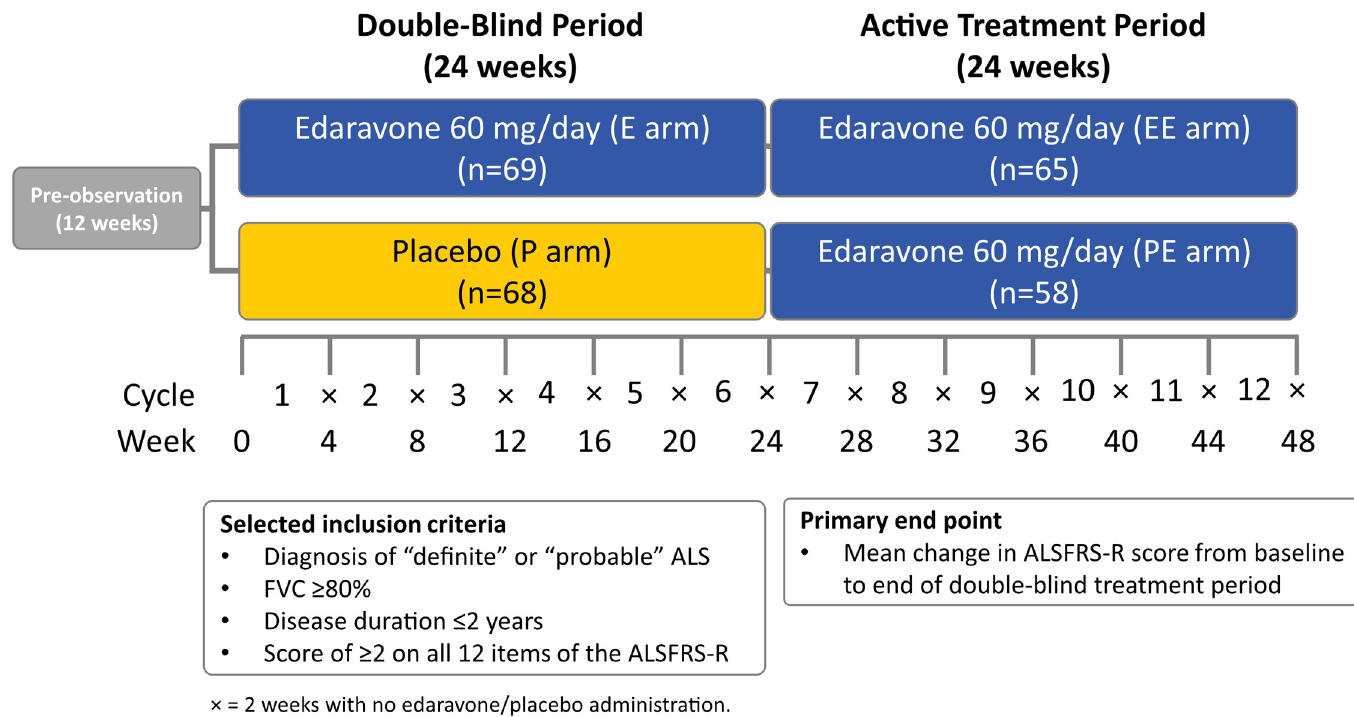
Fig 1. Study design for edaravone Study 19. After a 12-week pre-observation period, eligible subjects were randomized to receive either edaravone or placebo during a 24-week, double-blind period. After the double-blind period, subjects received open-label edaravone for 24 weeks. The diagram shows the treatment cycle and corresponding weeks, along with selected inclusion criteria and the primary end point. ALS, amyotrophic lateral sclerosis; ALSFRS-R, Amyotrophic Lateral Sclerosis Functional Rating Scale-Revised; E, edaravone; FVC, forced vital capacity; P, placebo.